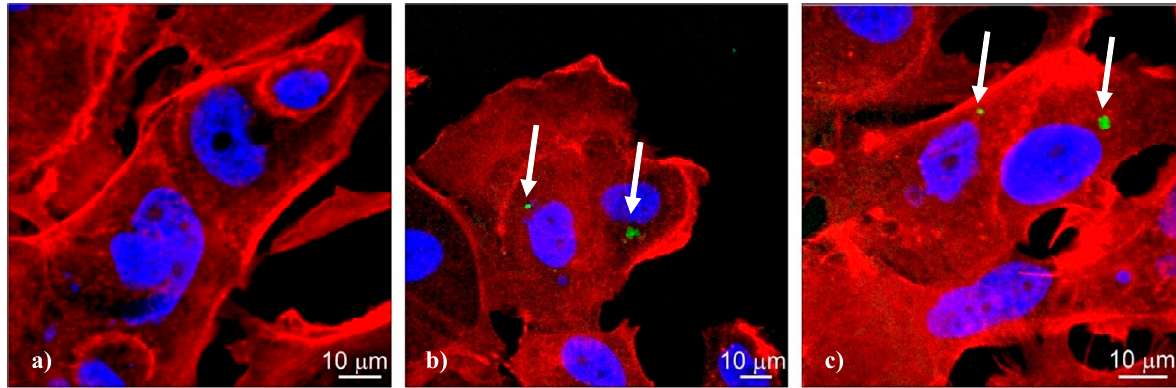
a) Figure 8. Confocal microscopy images of MCF-7 cells after 24-hour incubation with fluorescein labelled siRNA: ( a ) Bcl-2, Figure 8. ( b ) CBD-1/Bcl-2, ( c ) CBD-2/Bcl-2, ( d ) Mcl-1, ( e ) CBD-1/Bcl-2, ( f ) CBD-2/Mcl-1. The concentration of siRNA was 0.1 μ M and the dendrimer/siRNA charge ratio was 20:1. Arrows indicate complexes dendrimer/siRNA.